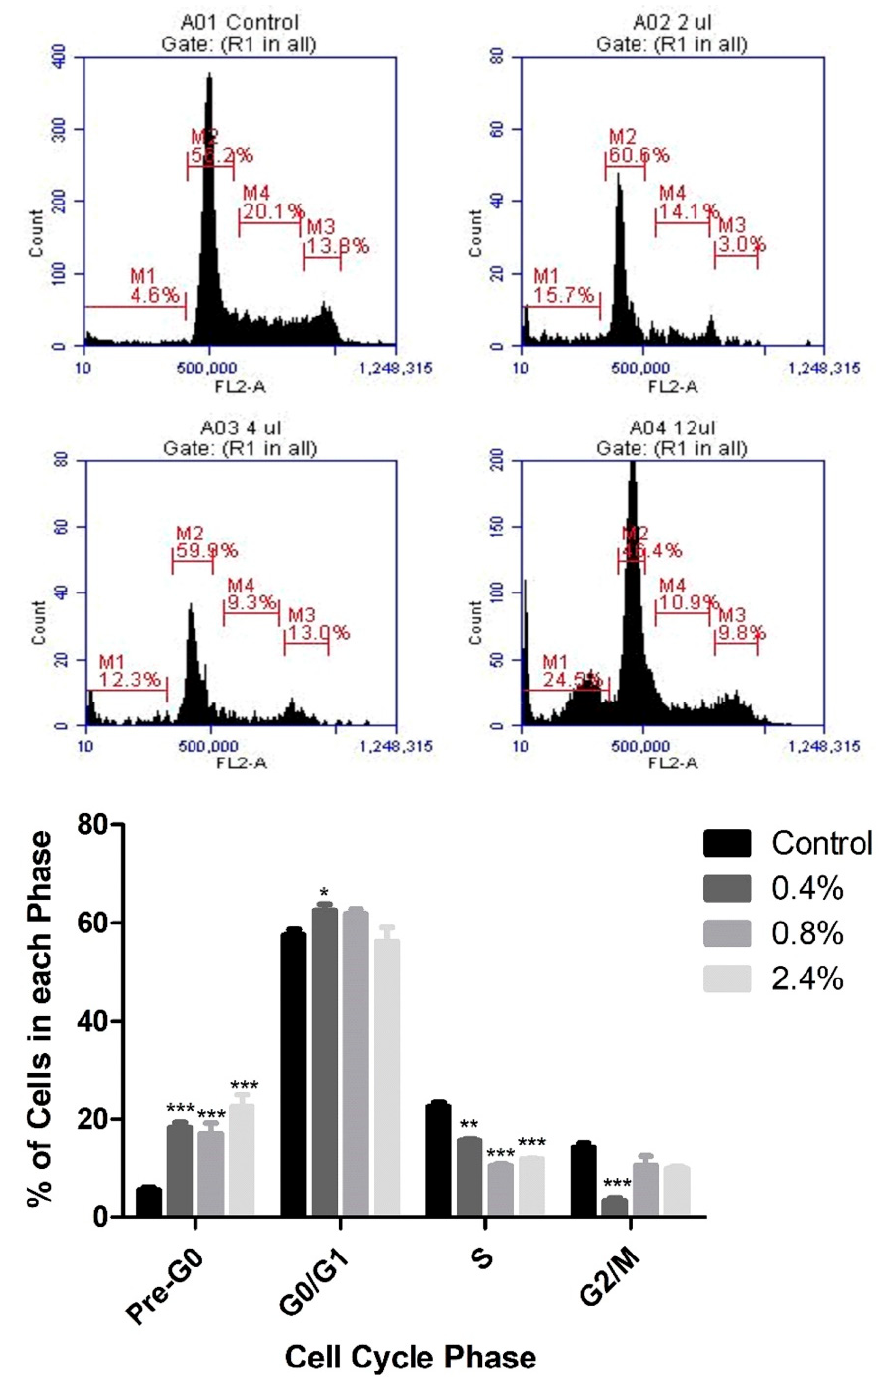
Figure 3. Dose-dependent effect of UD extract on cell-cycle distribution of U937 cells after 48 h of treatment. Cells are distributed into the different phases of the cell cycle according to their DNA content: pre-G0 cells are <2n (M1), G0/G1 cells are 2n (M2), S cells are >2n but <4n (M4), and G2/M- phase cells are 4n (M3). The histogram represents the means from three independent experiments +/ − SEM. *, **, and *** indicate p < 0.05, p < 0.001, and p < 0.0001, respectively, compared to the control group.